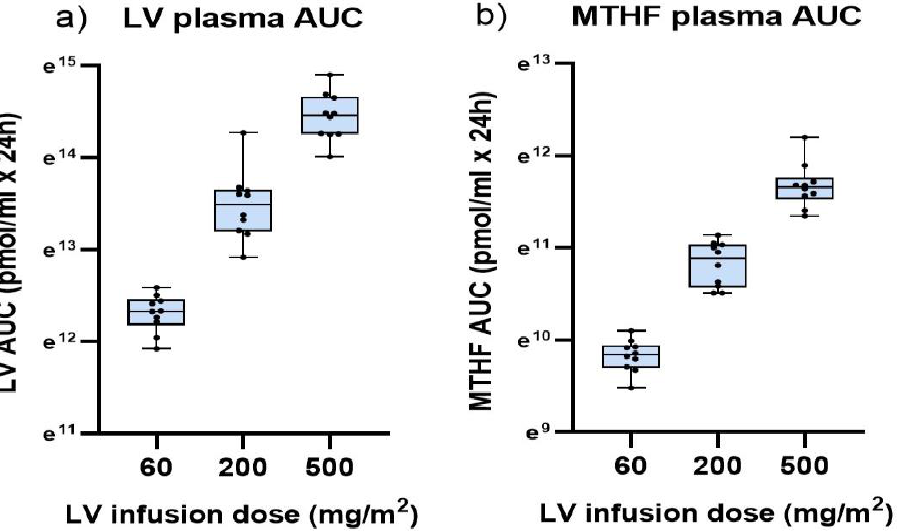
Figure 2. Dose-AUC relationship among patients receiving a two-hour intravenous infusion of 60, 200, or 500 mg/m 2 LV. The figure ( a ) shows the AUC (pmol/mL × 24 h) of LV and the figure ( b ) shows the AUC of MTHF in plasma of the 30 included patients. Due to the large difference in LV and MTHF levels, the scale is based on the natural logarithm.